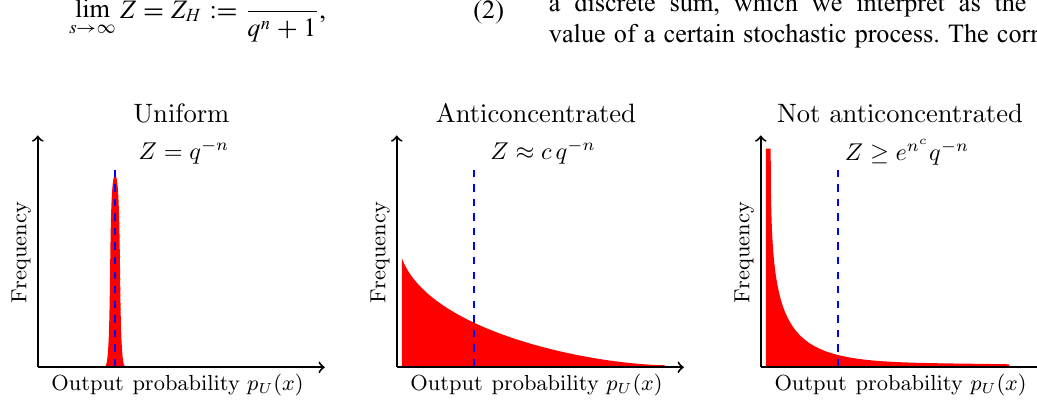
FIG. 1. A sketch of anticoncentration. In the three examples, the fraction (frequency) of bit strings x for which p U ( x ) = p is plotted against p . (This could be either for a fixed choice of U or averaged over random choice of U .) Since there are q n bit strings, the mean of this distribution is q − n (dotted blue line). For the uniform distribution, which is completely anticoncentrated, all q n outcomes are allocated probability mass q − n and the collision probability is Z = q − n . For globally Haar-random unitaries, the output probabilities are on average q − n but have some nonzero variance and the collision probability is Z ≈ 2 q − n . Whenever Z ≈ cq − n for some c independent of n , we call the distribution anticoncentrated. For low-depth RQCs, the mean output probability is q − n but the variance is much larger and the collision probability is much larger than q − n . Most of the probability mass is concentrated onto a few measurement outcomes, while the vast majority of the outcomes are assigned a very small amount of mass, leading to the divergence in the frequency that p U ( x ) is close to 0 depicted in the